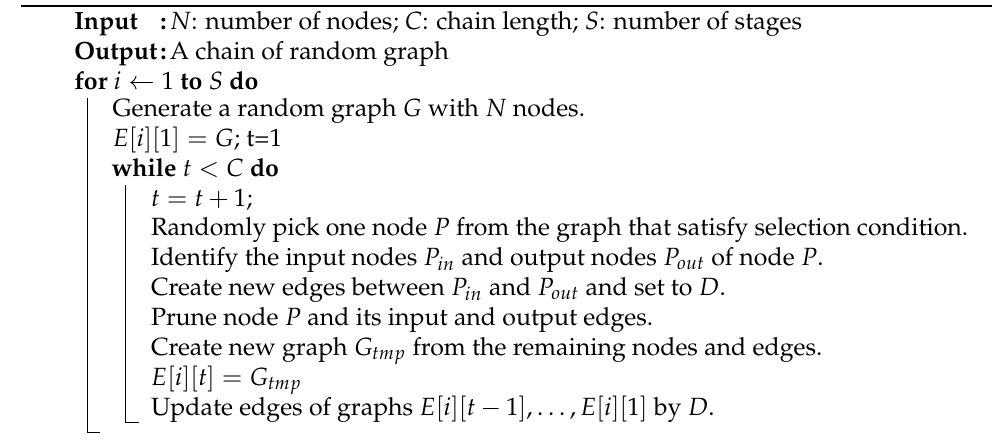
Figure 4. An example of a chain of random models. ( a ) The first generated random graph has six nodes and one input (number 0) and one output (number 5). ( b ) The random graph after removing node number 1. ( c ) The random graph after removing node number 4. The compensating edges (shown in red color) will be added later to all previous graphs. Algorithm 1: Generate a chain of random